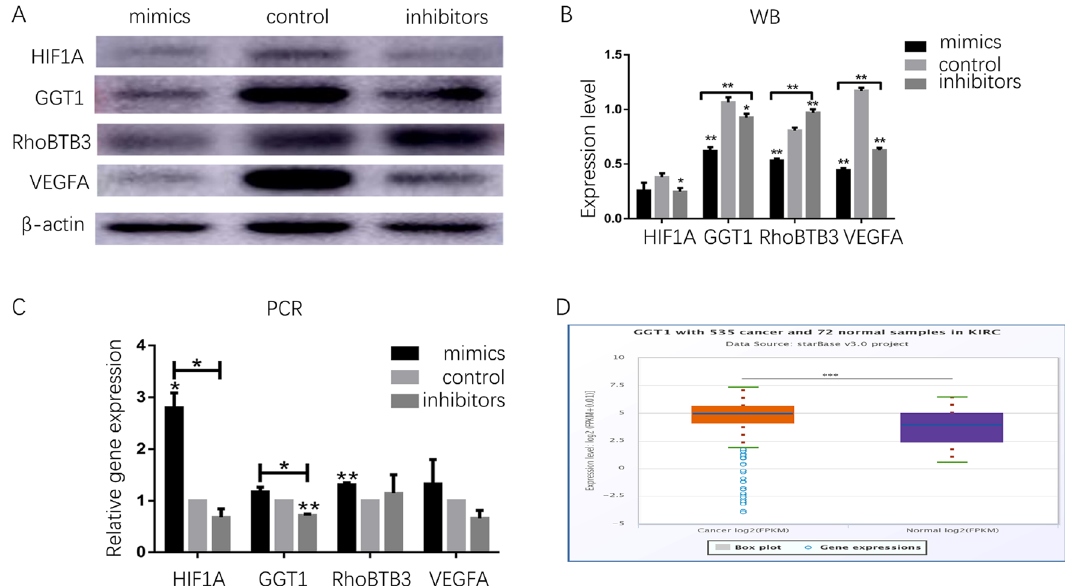
Figure 4. miR-142-3p regulates RCC migration and invasion via hypoxia and GSH pathways by targeting RhoBTB3. 786-O cells were transfected with miR-control, miR-142-3p-mimics, and, miR-142-3p-inhibitors. Protein expression of RhoBTB3, hypoxia, and GSH pathway-related biomarkers, including HIF1A, VEGFA, and GGT1 using Western blot ( A ) (the original blots/gels are presented in Supplementary Fig. 3, the samples derive from the same experiment and that gels/blots were processed in parallel). The mRNA and protein expression of RhoBTB3, HIF1A, VEGFA, and GGT1 in 786-O cells was determined using qRT-PCR and Western blot, respectively ( B , C ). Expression of GGT1 differed significantly between RCC and the normal adjacent tissues (enhanced in KIRC, D , P <